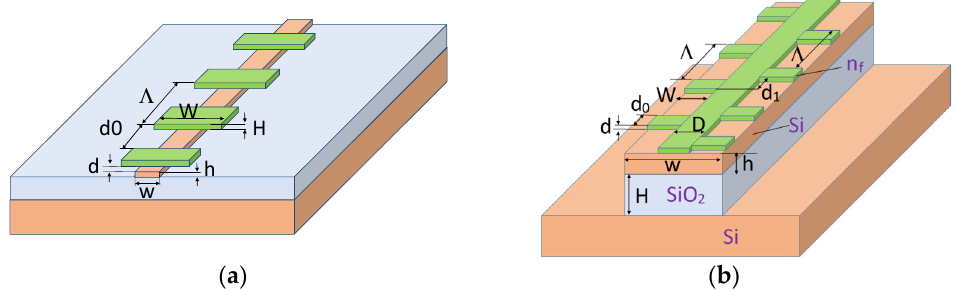
Figure 1. Grating coupling element based on a silicon optical waveguide in the SOI structure. ( a ) Waveguide structure with a symmetric grating for the TE 0 - TE 0 diffraction. ( b ) Waveguide structure with an asymmetric grating for the TE 0 -TE 1 diffraction where n f is refractive index of segmented grating (in our case polymer SU-8). The meaning of the structure parameters is evident from the figure and are the subject of the optimization for particular sensor